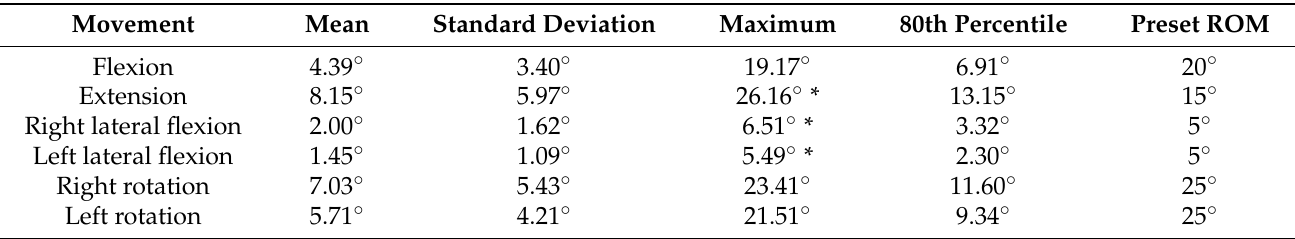
Table 3. ROM results of Profile 1 (After outlier filtering, the analyzed data for the Profile 1 supposed a 98% of the total flexion-extension raw data, a 96% of the total lateral flexion raw data, and a 99% of the total rotation raw data). The cases where the maximum ROM of the subjects reported by the ENLAZA inertial sensors exceeded the preset ROM defined for the profile are marked with an asterisk.